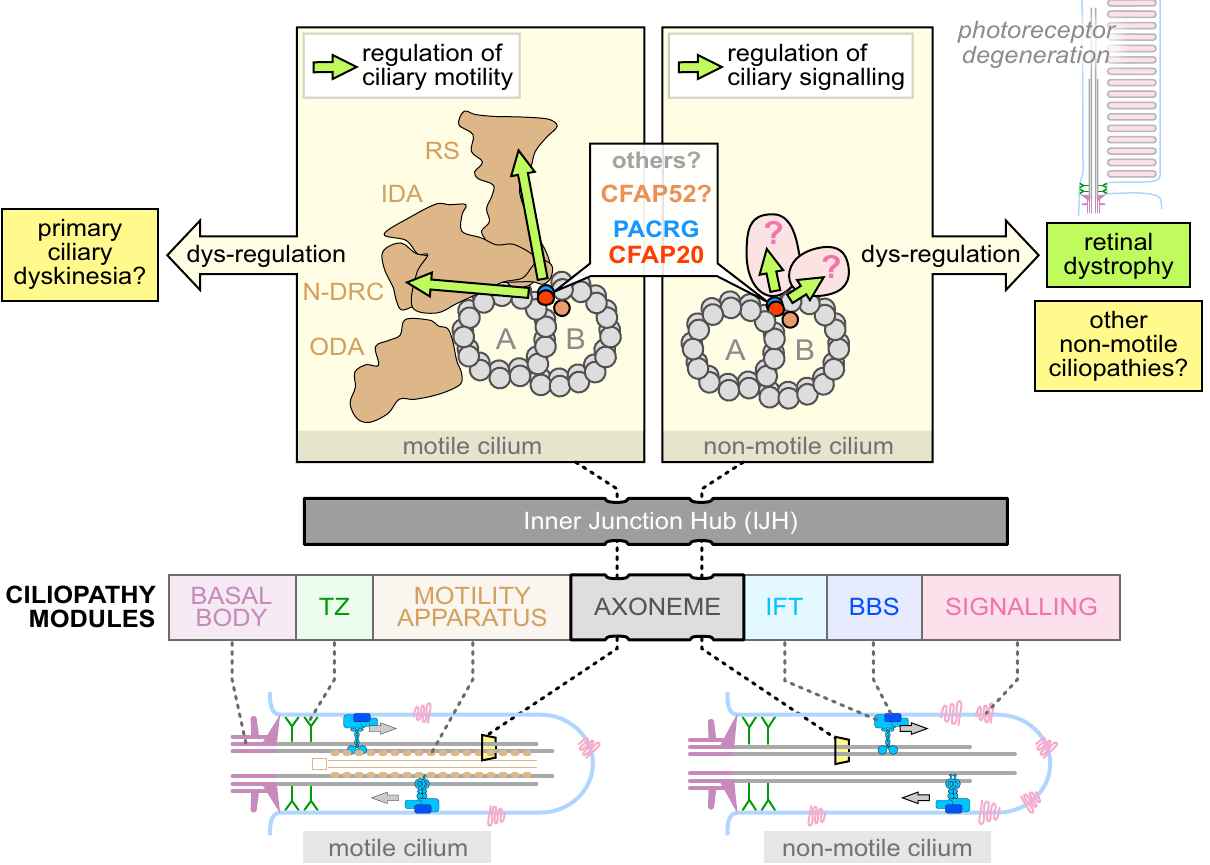
Fig. 8 | Model depicting the Inner Junction Hub (IJH) as regulatory domain in motile cilia and previously uncharacterised ciliopathy (retinal dystrophy) region that in fl uences the signalling functions of non-motile (primary)